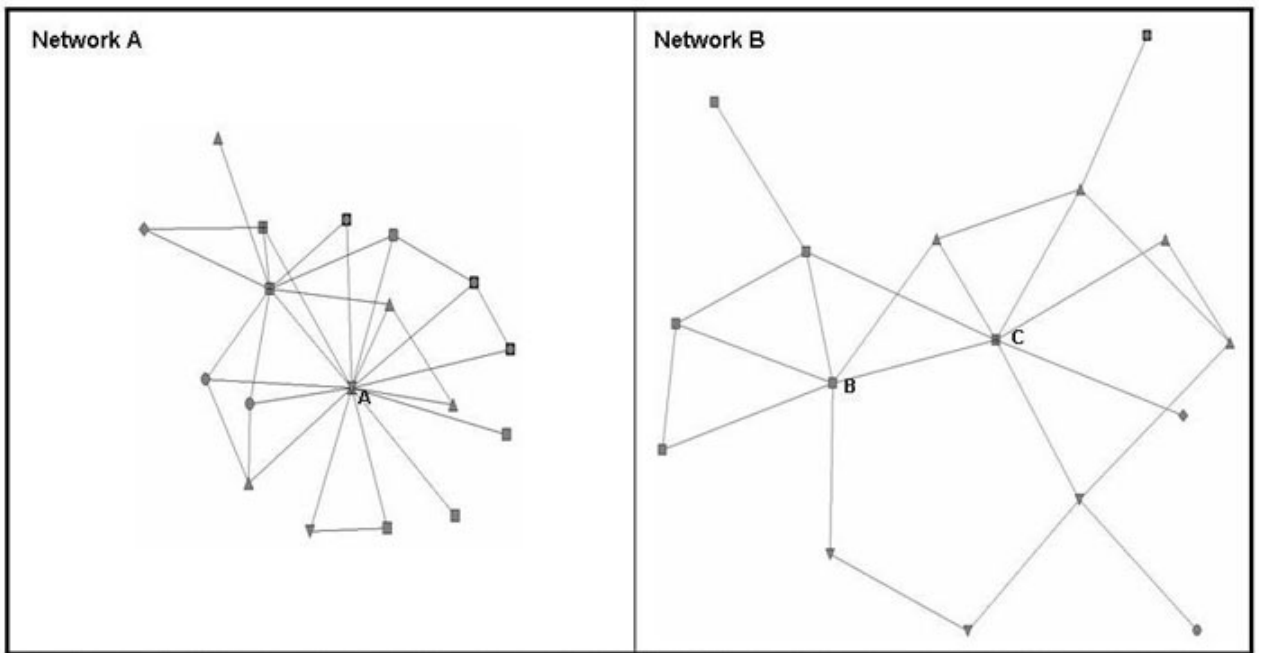
Fig. 3. Rule-making